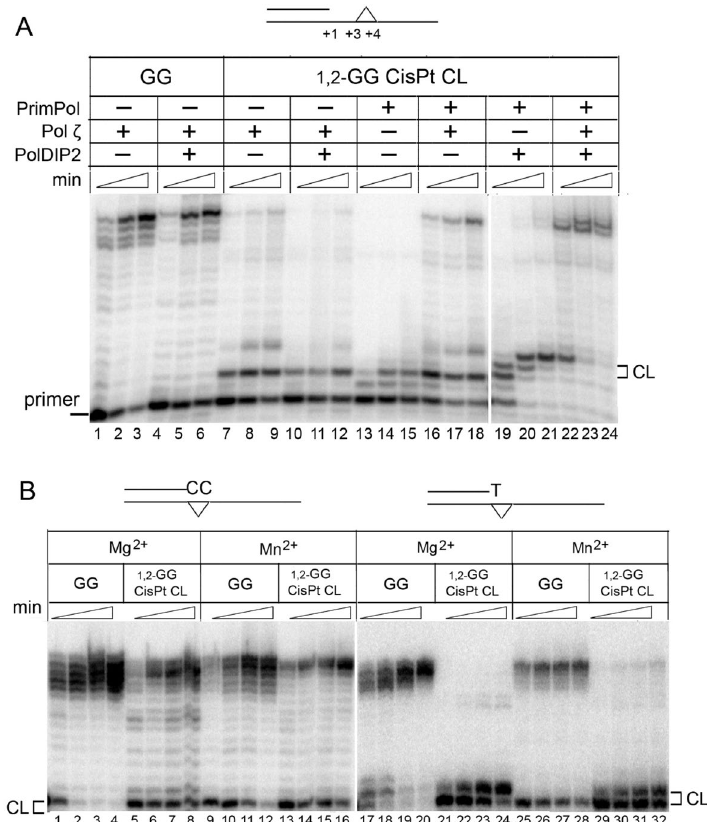
Figure 2. ( A ) The TLS on DNA substrate with the 1,2-GG CisPt CL by PrimPol in combination with Pol ζ. Reactions were carried out on a DNA substrate with the 1,2-GG CisPt CL at the + 3–4 position downstream of the primer in the presence or in the absence of PolDIP2. ( B ) Extension of correctly paired and mispaired primer termini by Pol ζ. Extension reactions were carried out on DNA substrates with matched primer termini (CC) paired with undamaged GG or the 1,2-GG CisPt CL and mismatched primer with the 3 ′ -end T paired with the 2